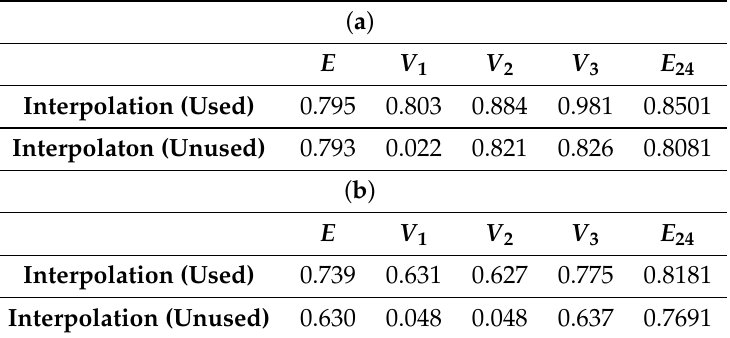
Table 1. Comparison of the credibility for each sensor. Each cell indicates the credibility. The sensors V 1 , V 2 , and V 3 respectively correspond to the solar wind speed of ACE, STEREO-A, and STEREO-B. The sensors E and E 24 respectively correspond to the high-energy electron flux and its flux 24 h ahead. ( a ) Case study 1 (Fault of a single sensor). The sensor of ACE for the solar wind speed is faulted; ( b ) Case study 2 (Faults of two sensors). The sensors of ACE and STEREO-A for the solar wind speed failed.